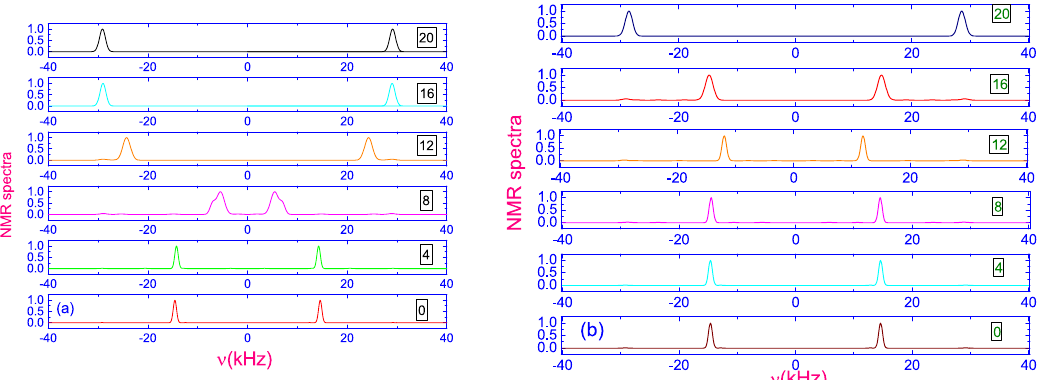
Figure 14. The deuterium NMR spectra I ( ν ) of 5CB-d 2 calculated for a number of times τ = 0,4,12,16, and 20, both for the case of strong ( a ) and weak ( b ) anchoring, respectively. In both sets of spectra the solid lines show the turned-off process ( E = 0)